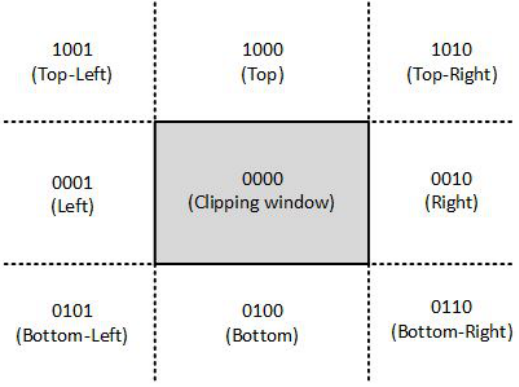
Figure 2. The codes for the nine regions of the Cohen-Sutherland algorithm in the two-dimensional